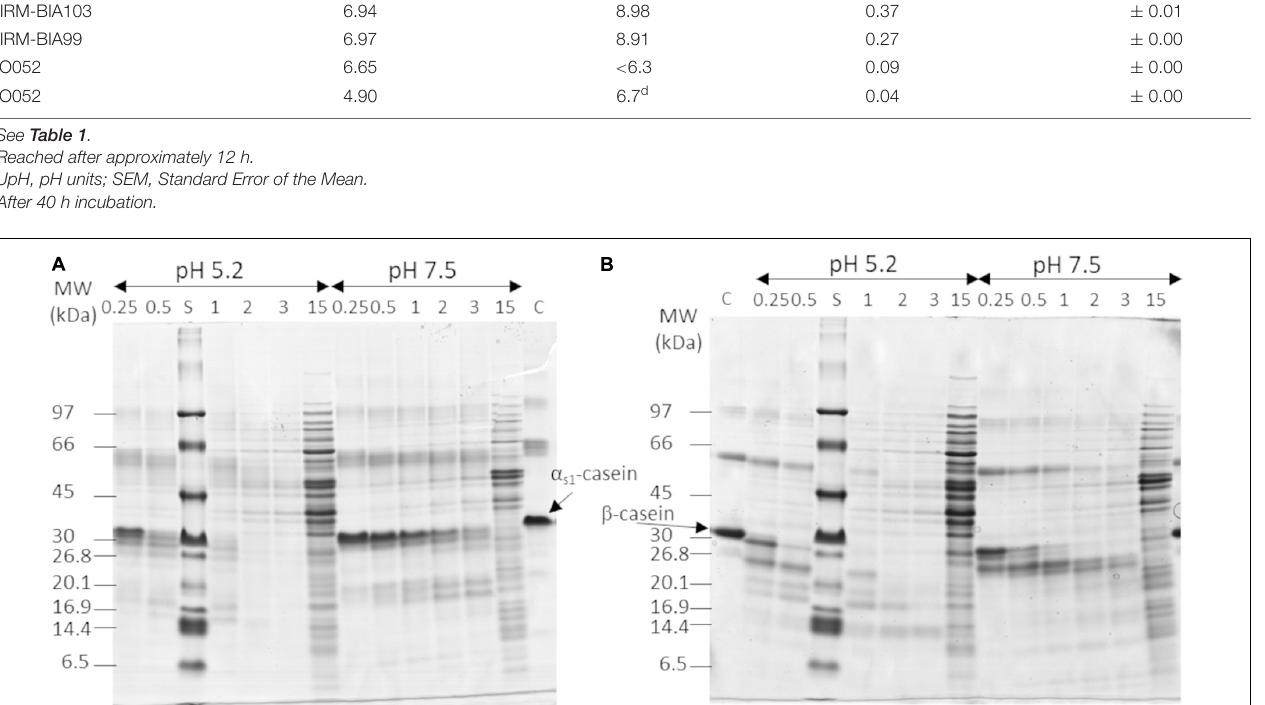
TABLE 2 | Growth and acidification rates of three Lactobacillus helveticus strains possessing different CEP genes. Counts, log 10 CFU.mL − 1